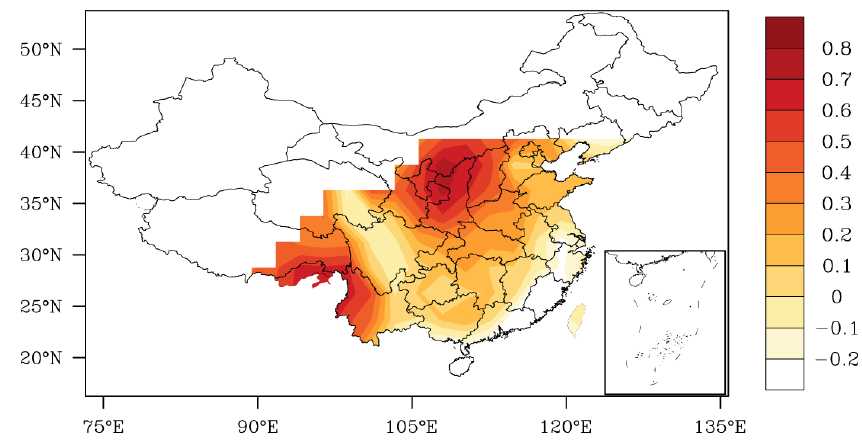
Figure 7 . Spatial distribution of Pearson correlation coefficient between lightning flash density and AOD over China .